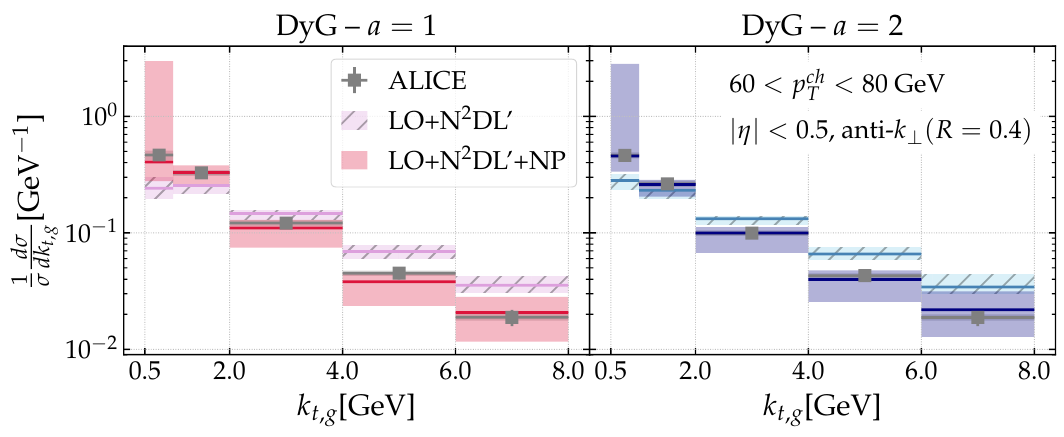
Figure 8 . Comparison between the analytic result obtained in this paper and the preliminary ALICE data [32] of k t,g .